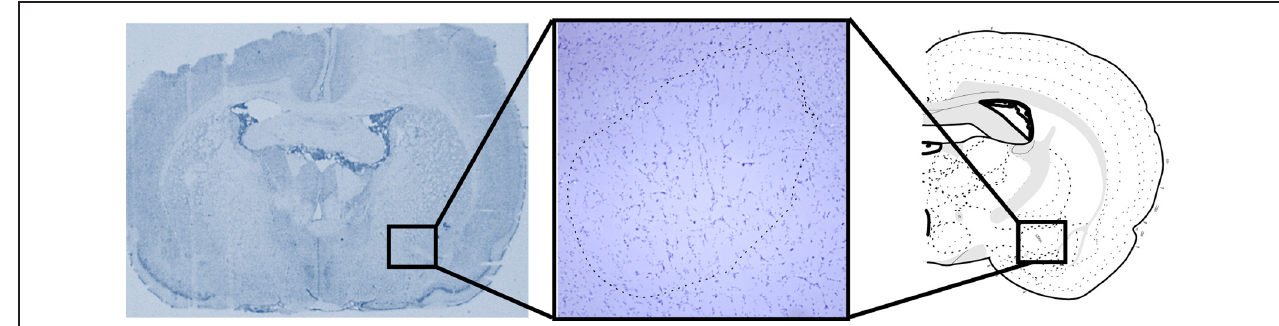
FIGURE 1 | Representative picture of the lesion sites in the Central Nucleus of the Amygdala (CeA). Atlas section according to Swanson (1998).